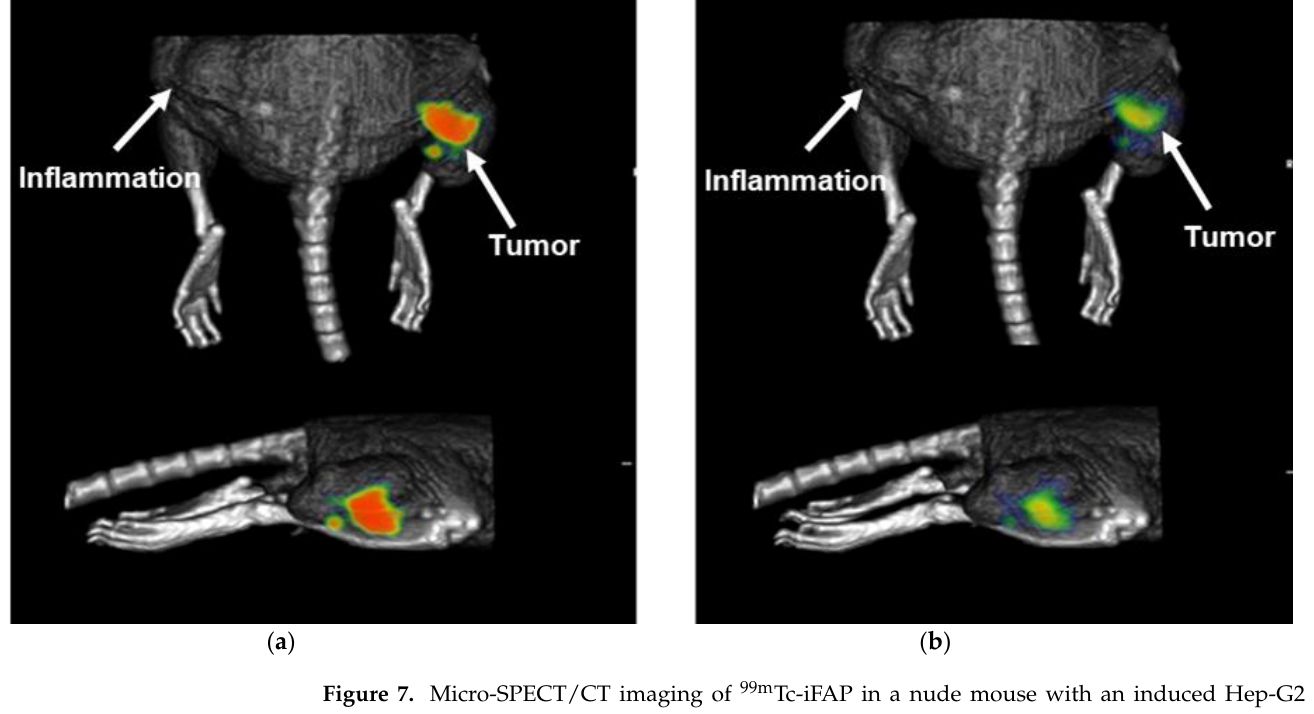
Figure 7. Micro-SPECT/CT imaging of 99m Tc-iFAP in a nude mouse with an induced Hep-G2 tumor at ( a ) 30 min (SUV max of 5.6, right thigh), and ( b ) 24 h (SUVmax of 2.4, right thigh) after radiopharmaceutical administration. It is worth noting the significant radiopharmaceutical uptake in the right thigh of the mouse where the cancer cells were inoculated (positive control), whereas, in the left thigh, where an inflammatory process was induced with killed bacteria (negative control), no radiotracer uptake was observed .